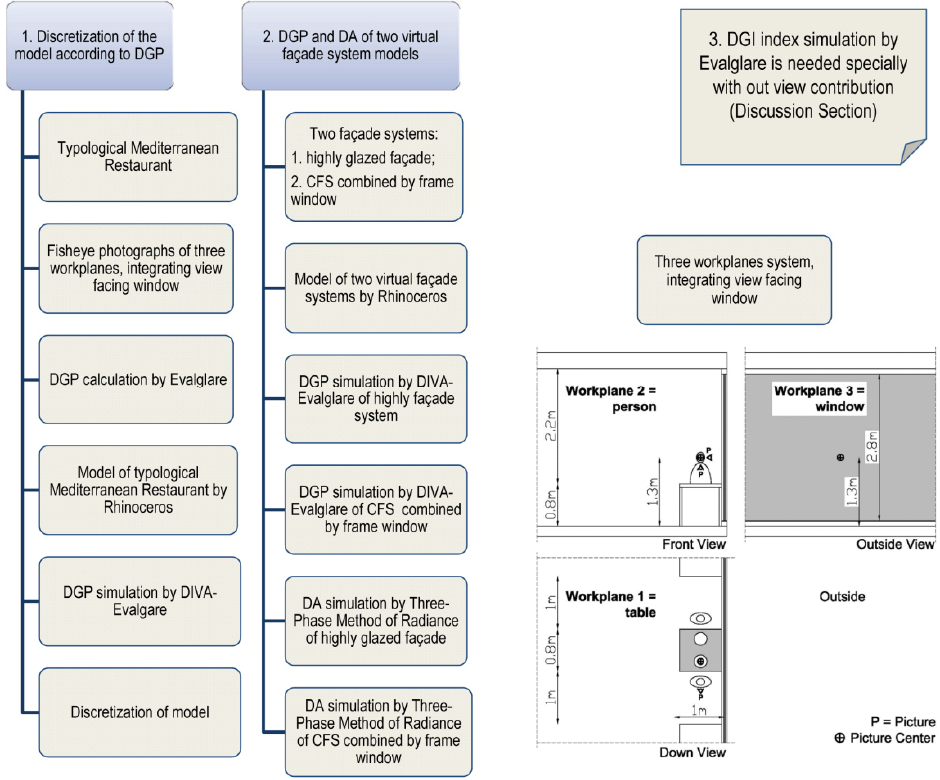
Figure 1. Methodology description and proposed three workplanes system for visual field evalua- tion.